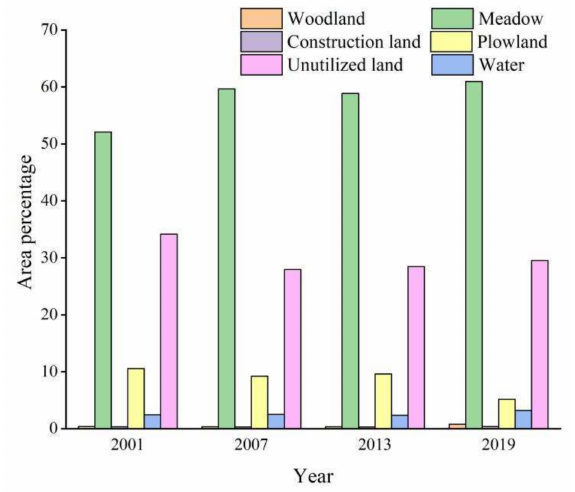
Figure 13. Areas of different land use types in different years in Central Asia.